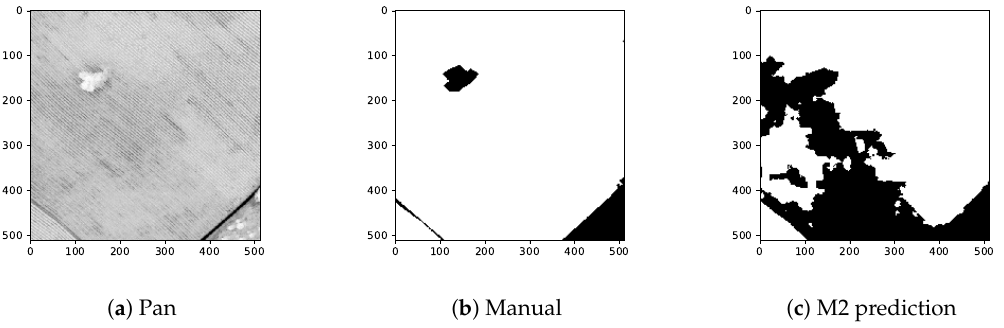
Figure 6. An example patch of size 512 × 512 pixels for M2 with missed detections, JI = 73%, Precision = 99%, Recall = 73%.